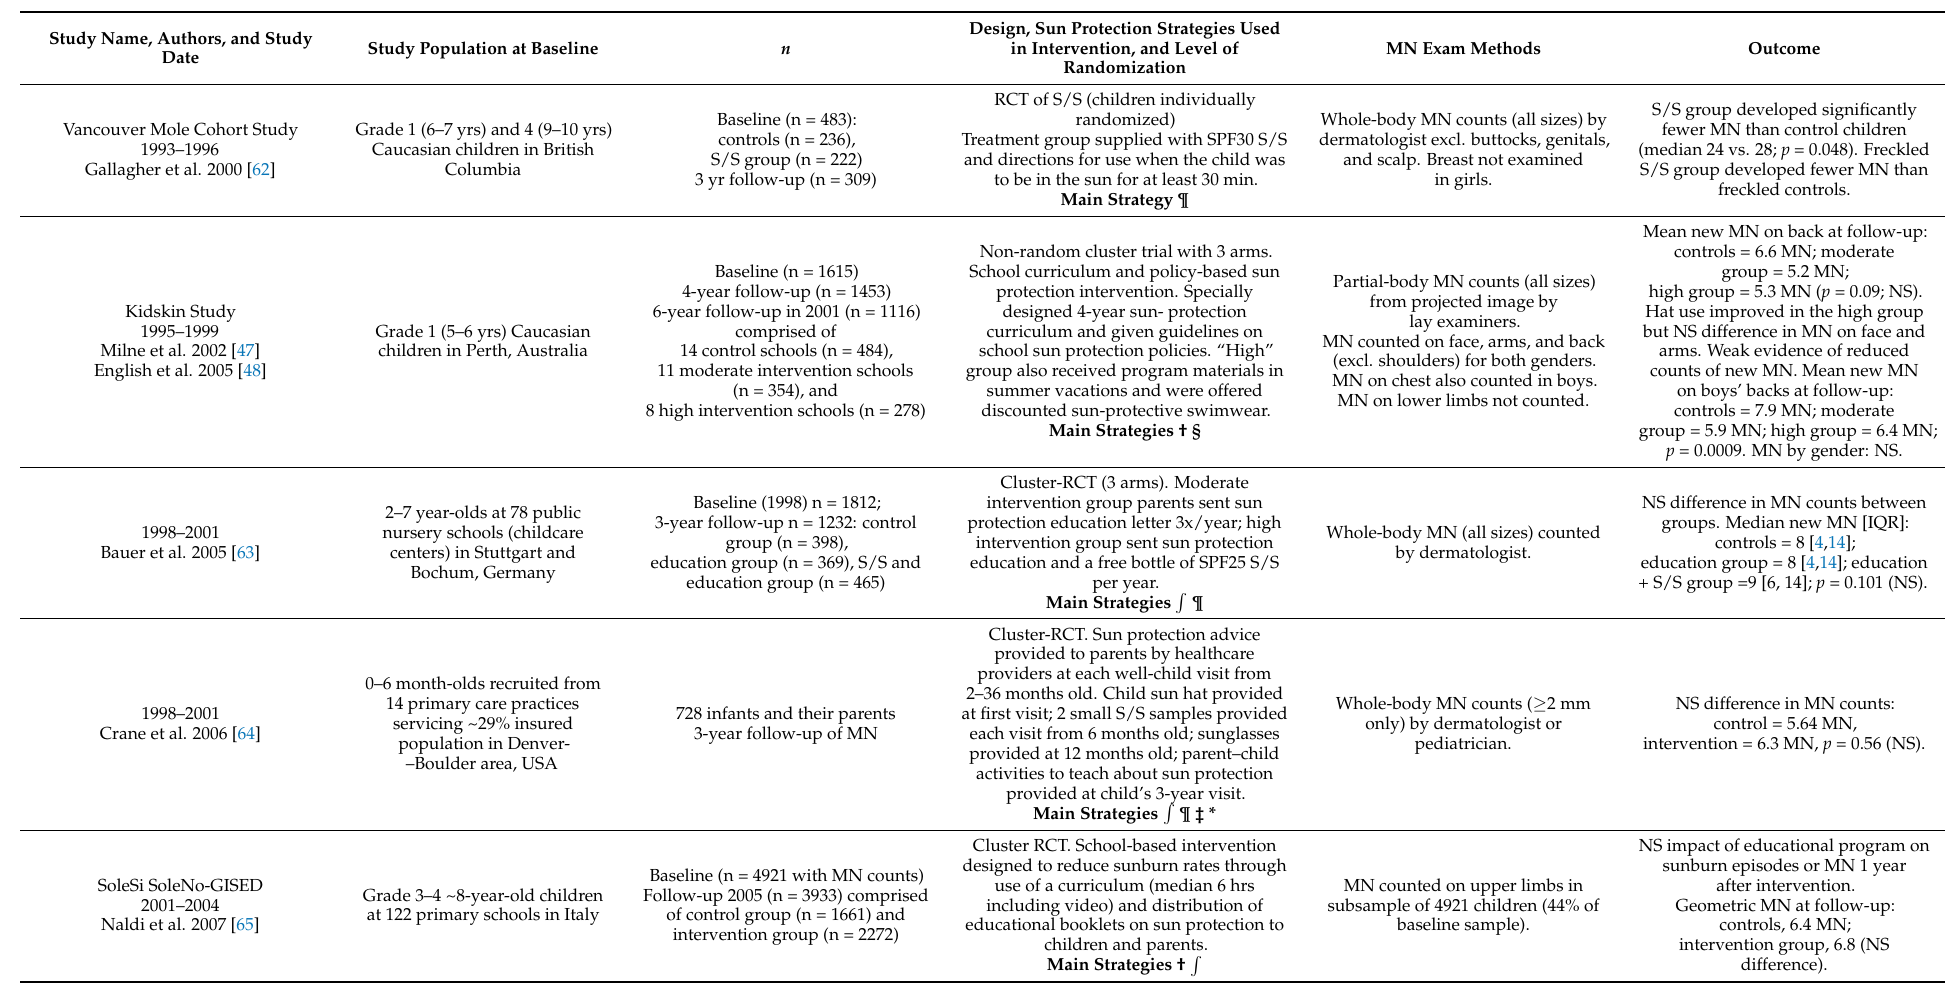
Table 4. Summary of the design and outcome of intervention studies published before December 2022 that aimed to reduce the number of melanocytic nevi (MN) developing in prepubescent